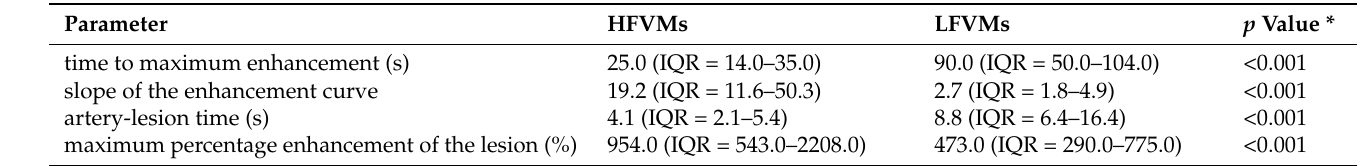
Table 1. Medians of the time to maximum enhancement, slope of the enhancement curve, artery- lesion time, maximum percentage enhancement of the lesion for high-flow vascular malformations (HFVMs) and low-flow vascular malformations (LFVMs).